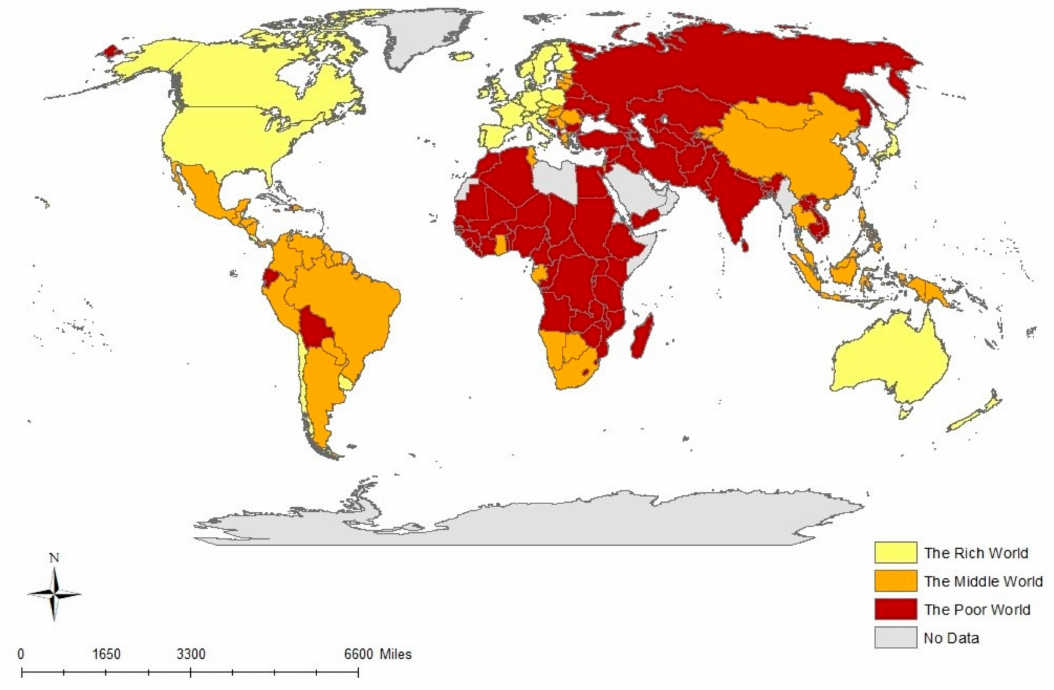
Figure 1. A three-group